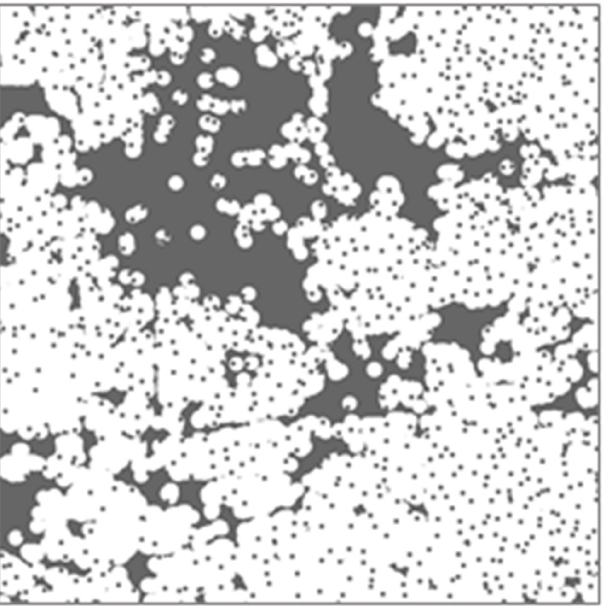
Figure 3. Distribution area of weak coverage points (the white area is weak coverage area).